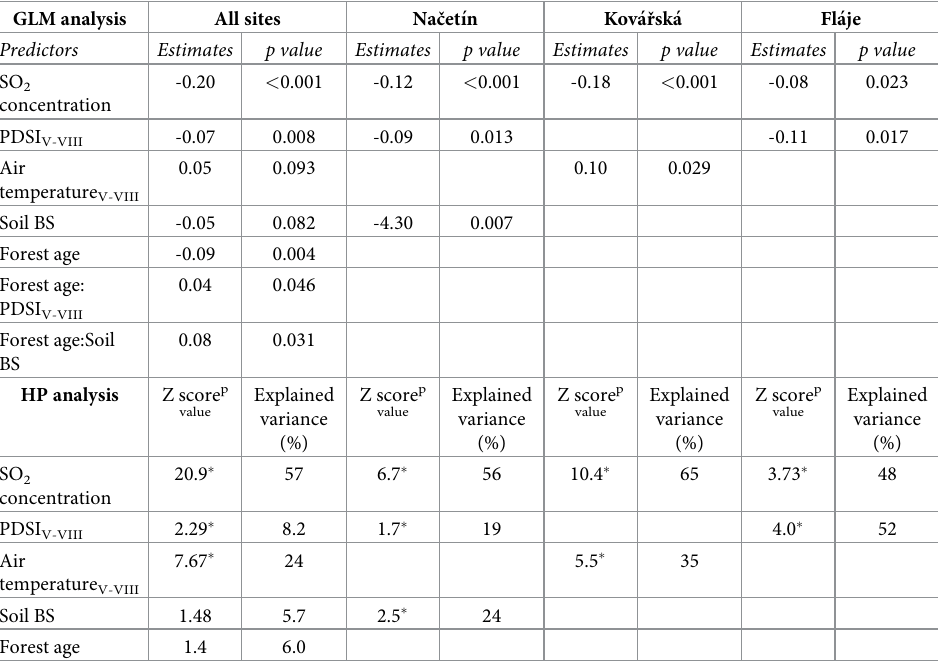
Table 3. Assessment of the best (lowest AIC criterion) general linear model (GLM) with Hierarchical Partitioning (HP) analysis applied to annual tree-ring width index for the period 1979–2017. Asterisks in HP analysis dentote p <